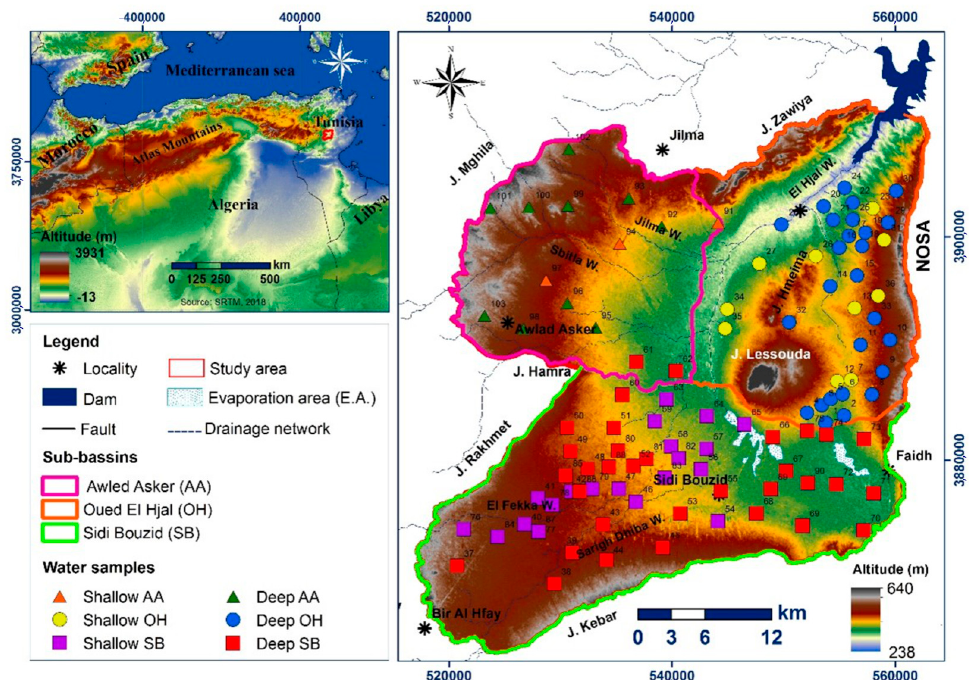
Figure 1. Location of the study area: Sidi Bouzid basin.